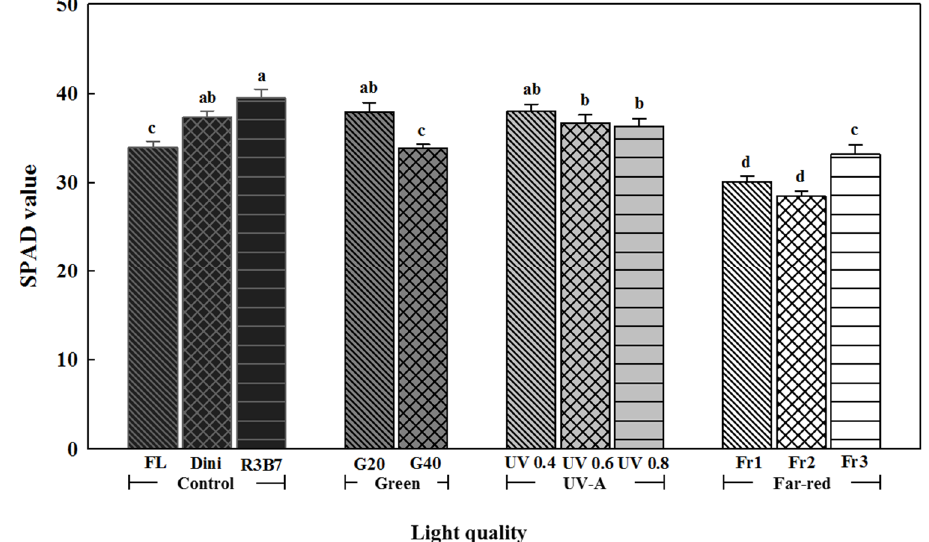
Figure 6. The effects of the light quality on the SPAD value of ‘Mini Chal’ tomato ( Solanum lycopersicum L.) measured 21 days after start of treatment. Refer to Figure 1 for details on the light qualities. Vertical bars indicate the mean ± SD ( n = 15). Different letters above the bars indicate significant differences by Duncan’s multiple range test at p = 0.05.